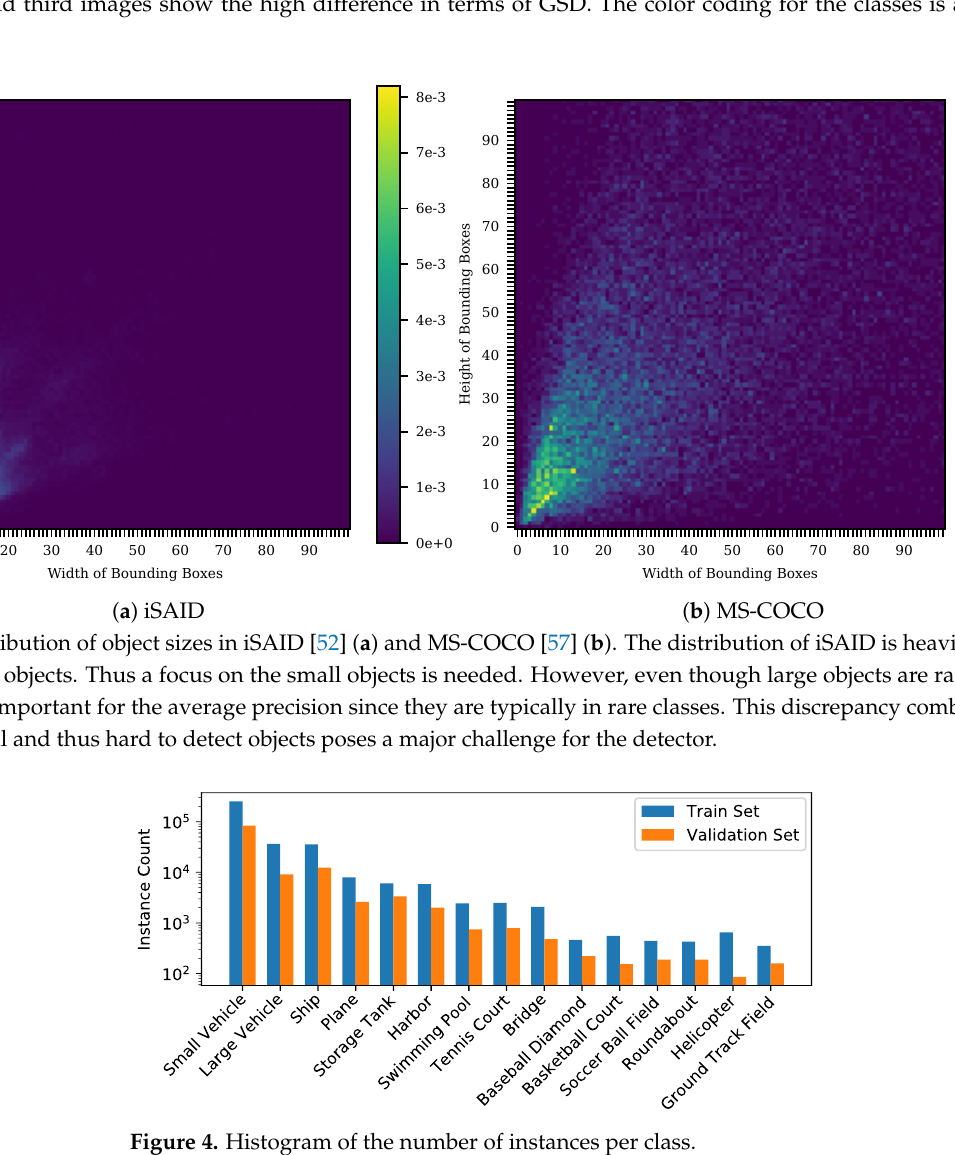
Figure 4. Histogram of the number of instances per